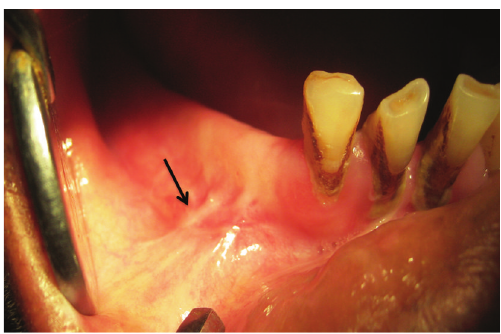
Figure 7: The follow-up intraoral photograph showing complete healing of the surgical site. Table 1: Classification of the types of neuropathic pain [1]. Based on anatomic location and Based on type of etiology